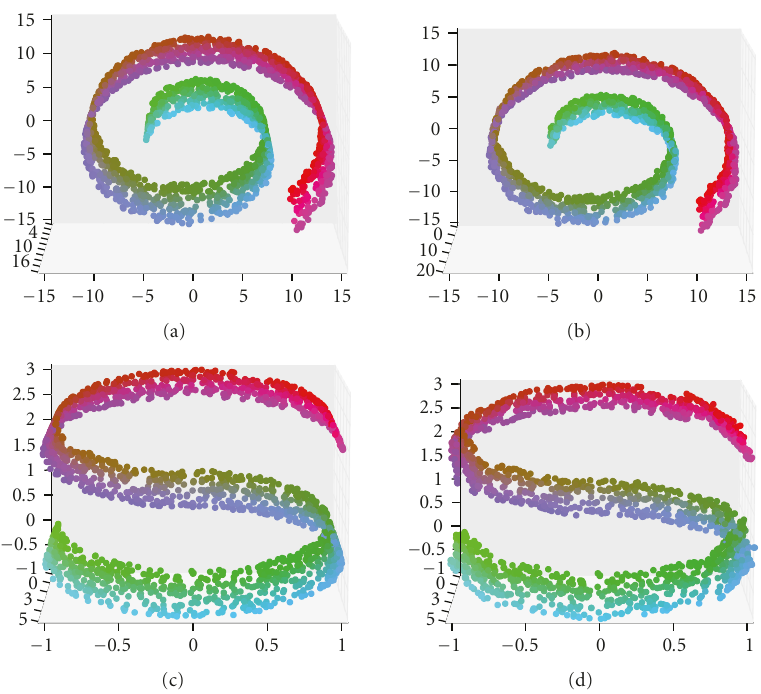
Figure 1: (a) Original SwissRoll, (b) regressed SwissRoll (108 planes), (c) original SCurve, (d) regressed SCurve (28 planes).